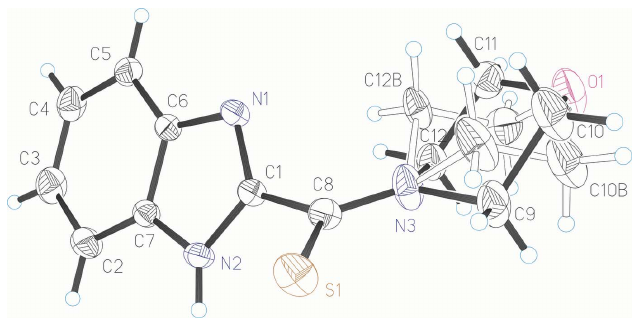
Figure 1 The molecular structure of the title compound with displacement ellipsoids drawn at the 50% probability level. Open bonds refer to the minor component of the disordered morpholide ring.